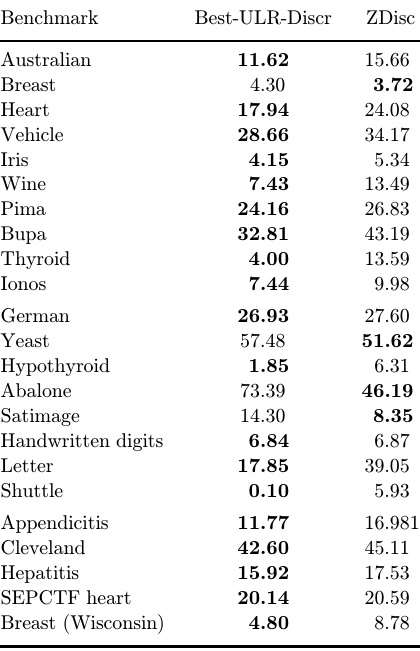
Table 8. Error rate for Best-ULR-Discr and Zdisc, respectively.